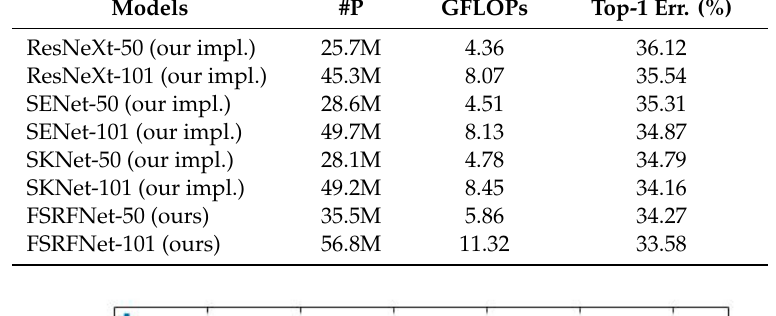
Table 2. Single 224 × 224 cropped top-1 error rates (%) on the Tiny ImageNet validation set and complexity comparisons. SENet, SKNet, and FSRFNet are all based on the corresponding ResNeXt backbones. The definition of FLOPs follows [56], i.e., the number of floating-point multiplication-adds. and #P denotes the number of parameters.